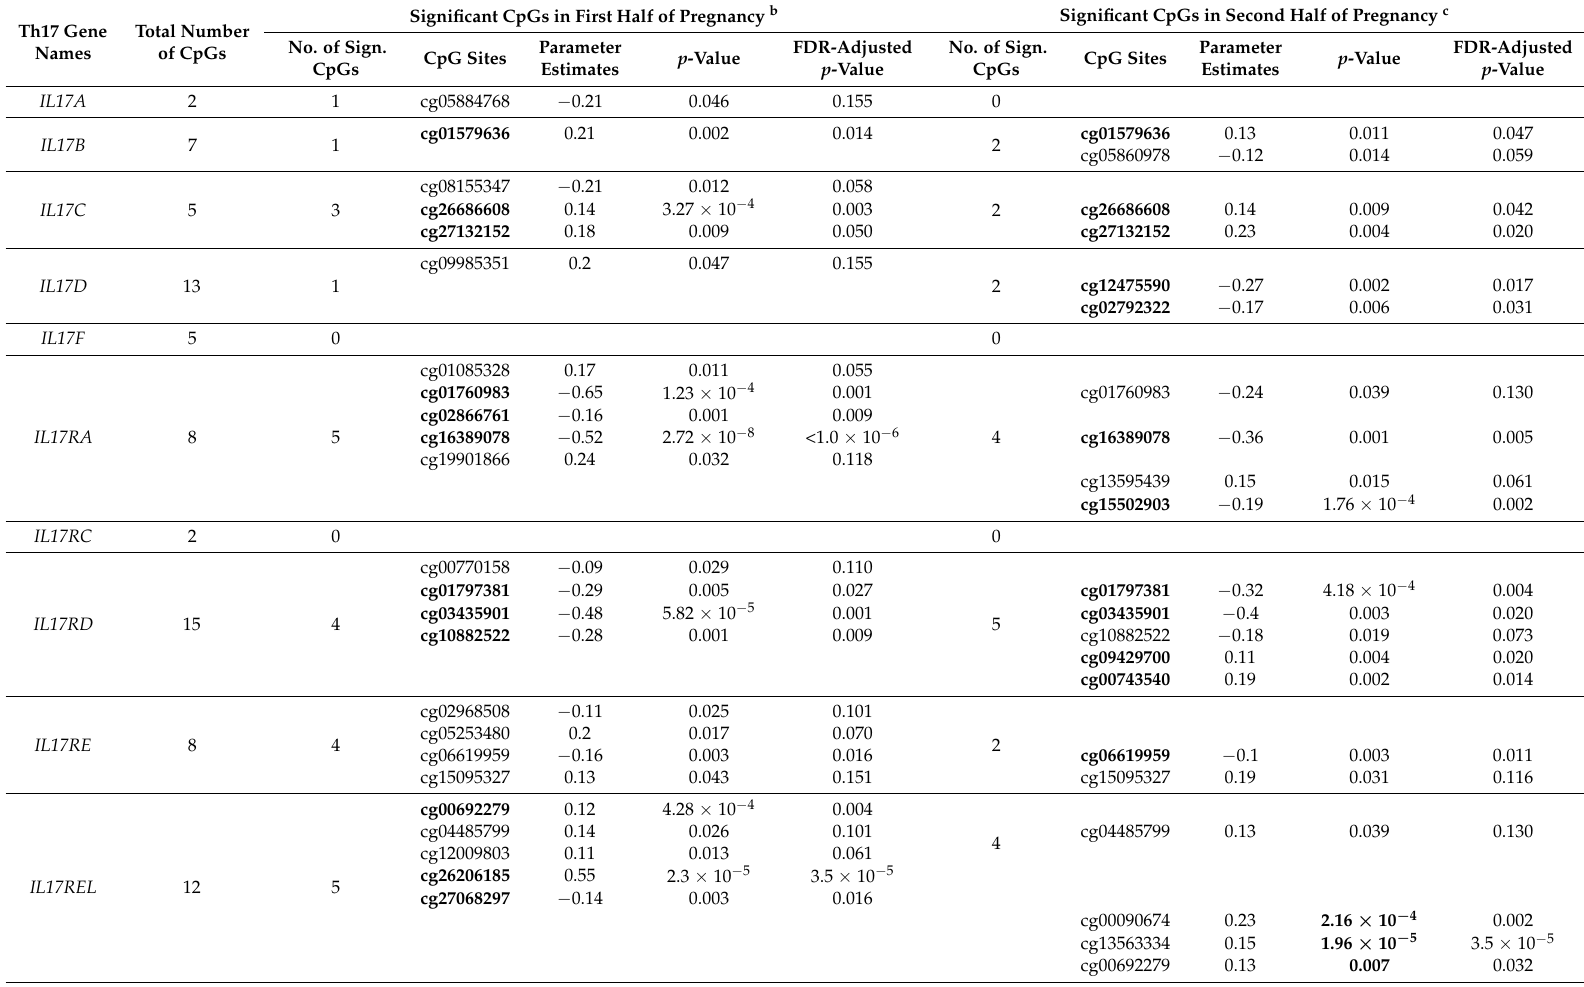
Table 4. Th17 CpGs showing statistically significant changes ( p ≤ 0.05) during first and second halves of pregnancy a